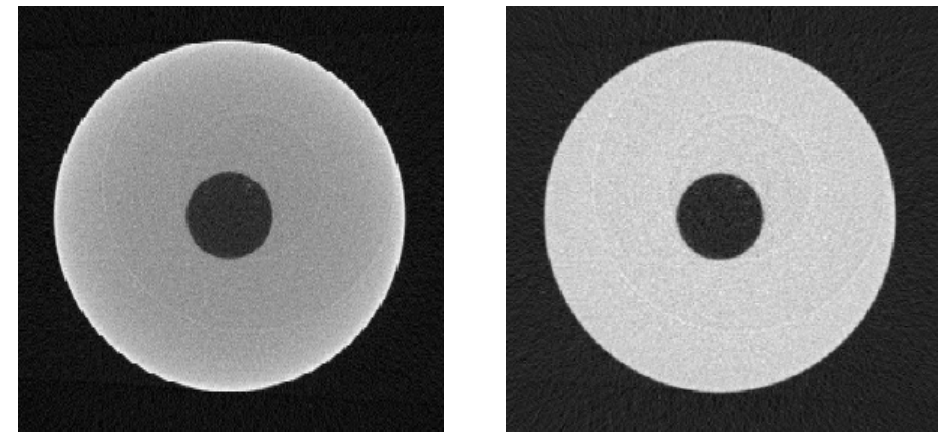
Sensors 2021 , 21 , x FOR PEER REVIEW Figure 13. Transverse plane CT images of the aluminium workpiece. Left : uncorrected. Right : beam hardening corrected.